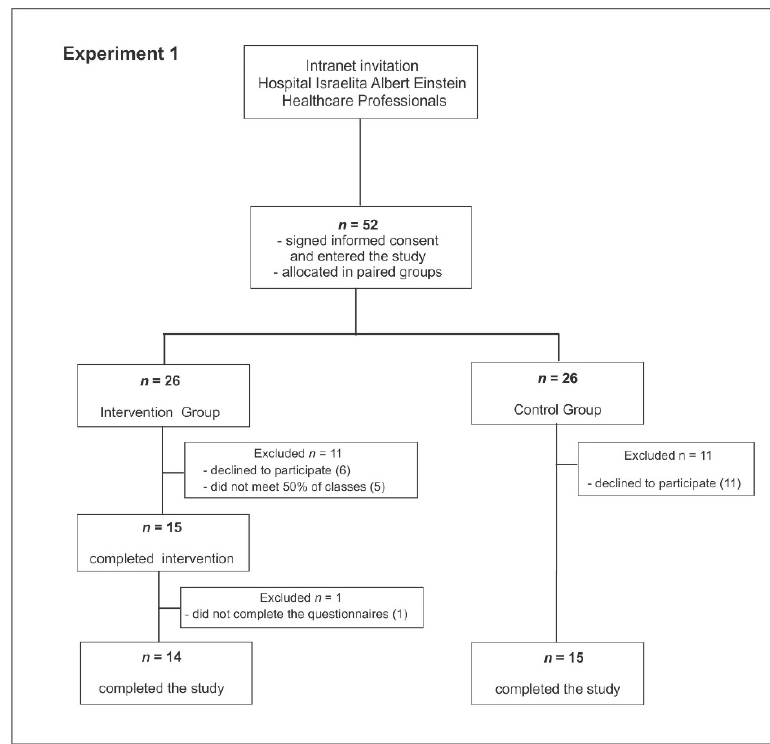
Figure 1. Consort flow chart (Experiment